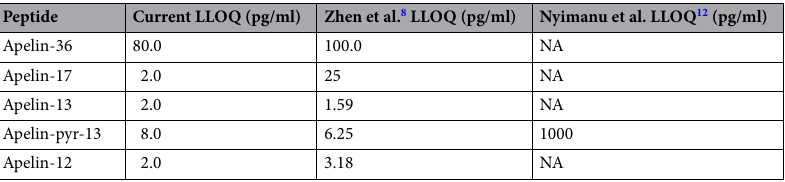
Table 8. Comparison of MS method